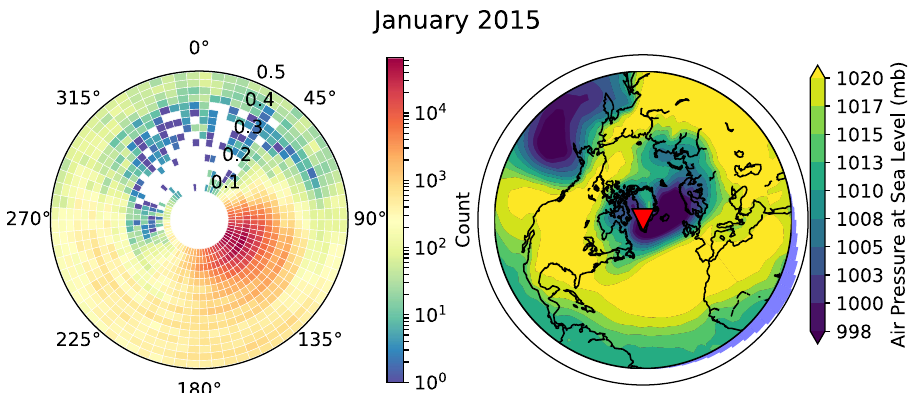
Fig. 2 Comparison of polarisation direction of measured Rayleigh waves and air pressure at sea level for January 2015 measured at station DY2G. Left: Polar histogram of polarisation directions as a function of frequency in Hz of measured Rayleigh wave with a DOP ≥ 0.95. Right: Map of monthly average air pressure at sea level, which acts as a proxy for ocean wave interactions. The histogram along the edge of the map is the sum of all polarisation directions of measured Rayleigh waves and the red triangle is the location of